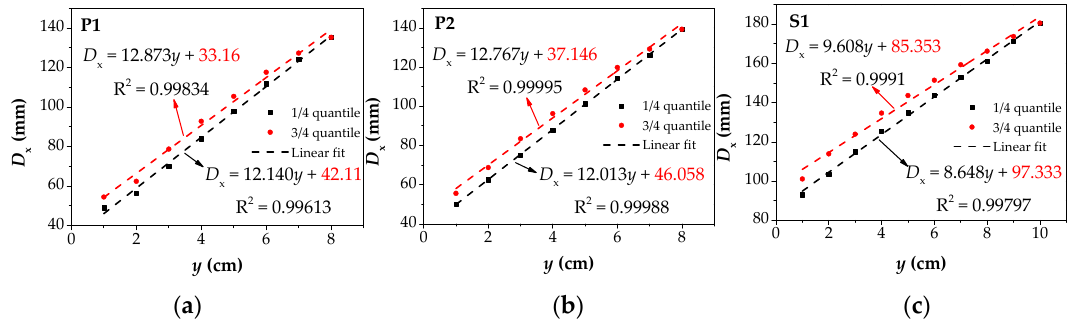
Figure 19. The Linear fitting results of D x of the three specimens: ( a ) the fitting results of P1; ( b ) the fitting results of P2; ( c ) the fitting results of S1. P1: the parallel wire strand made of seven steel wires; P2: the parallel wire strand made of 19 steel wires; S1: the steel strand; the red text in the graph represents the predicted value of corrosion width. D x : the intersecting point distance between curves of magnetic flux component of x direction at di ff erent lift o ff heights.